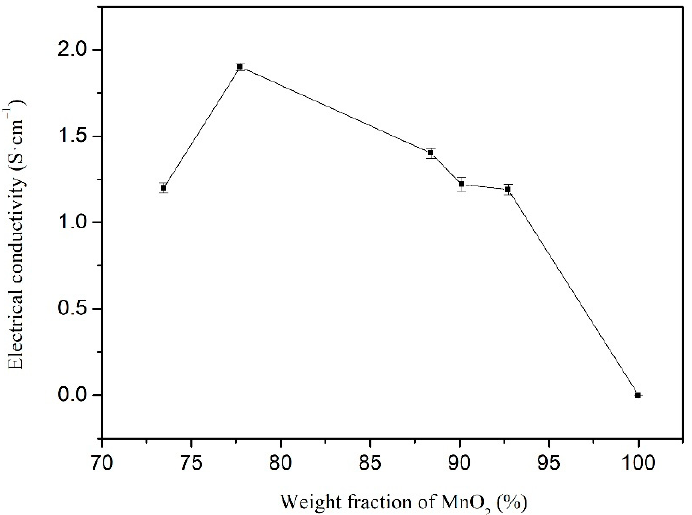
Figure 8. Electrical conductivity of PANI/MnO 2 composite with different weight fractions of MnO 2 and pure MnO 2.